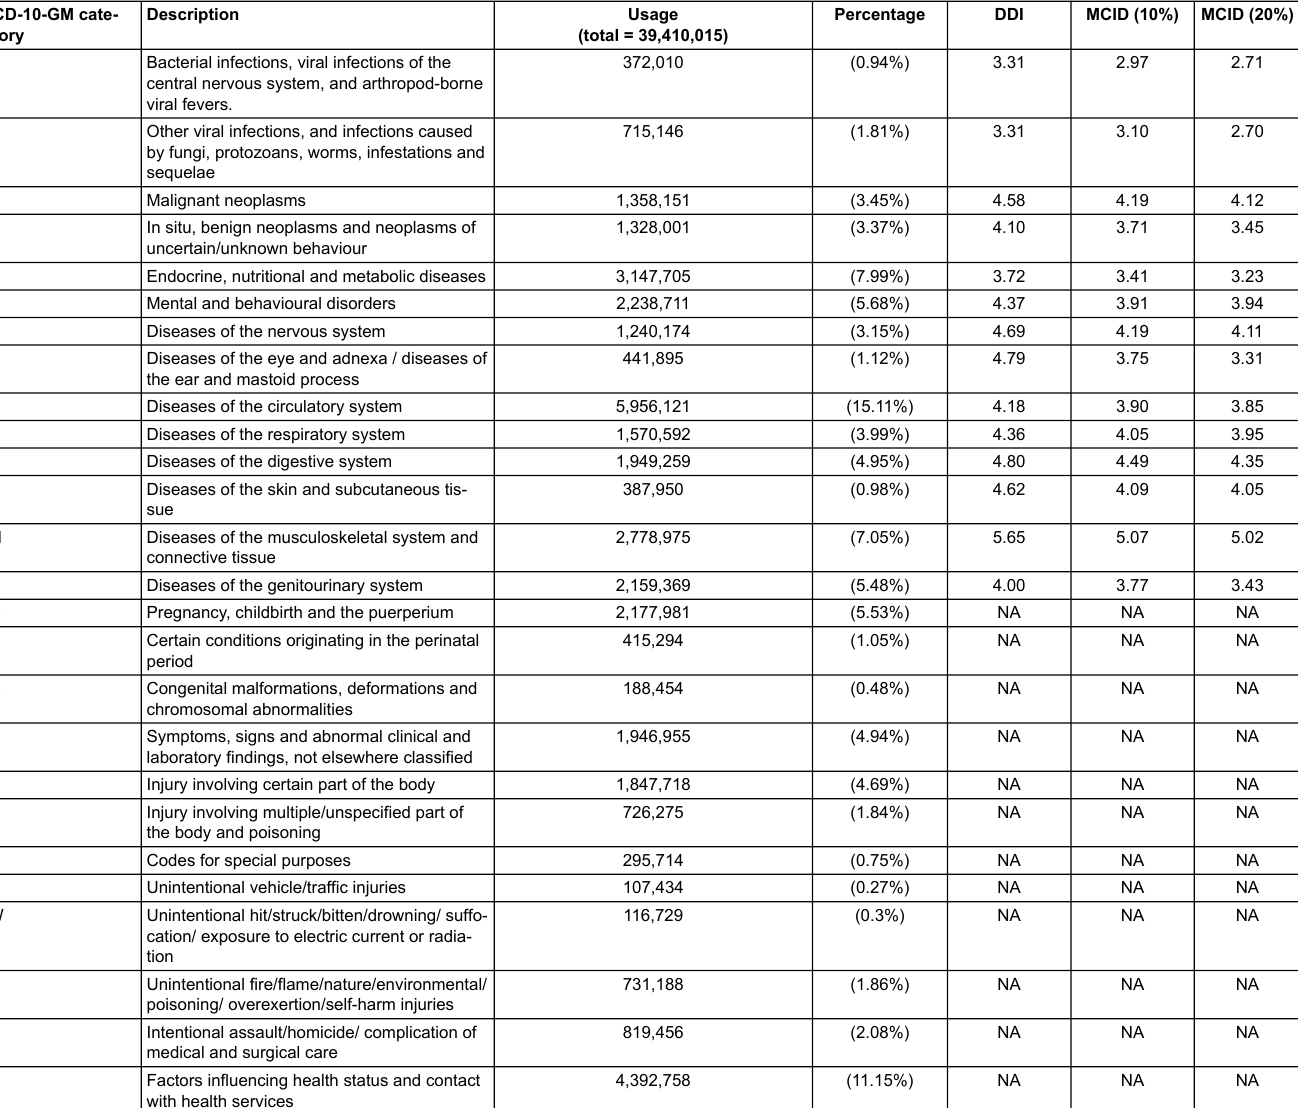
Table 2: Description of the ICD-10-GM categories. ICD-10-GM cate-